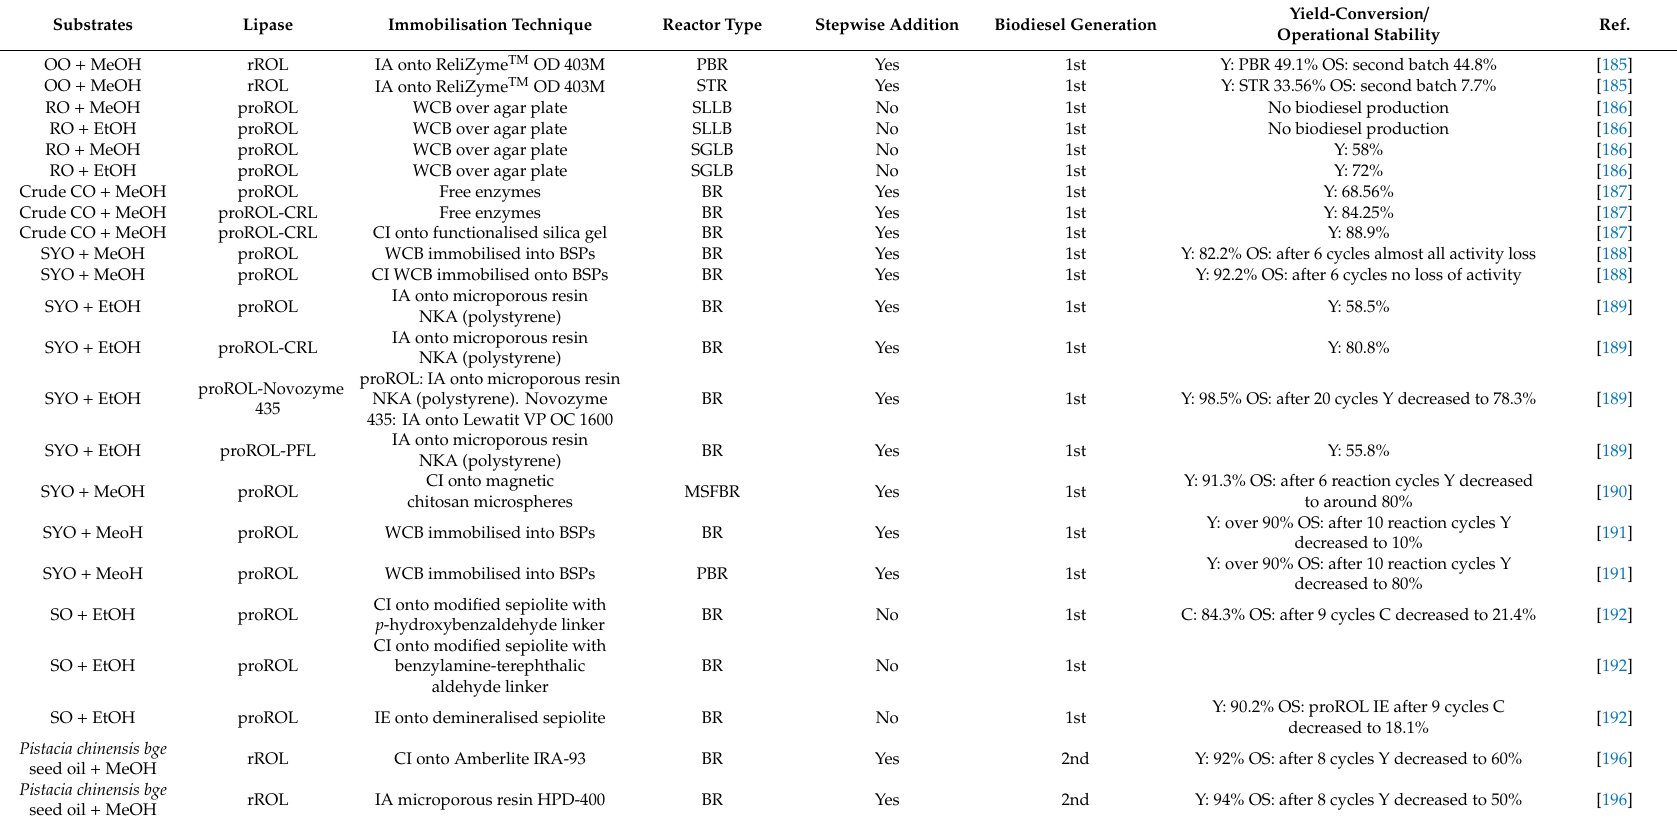
Table 5. Summary of biodiesel production with Rhizopus oryzae lipase as main